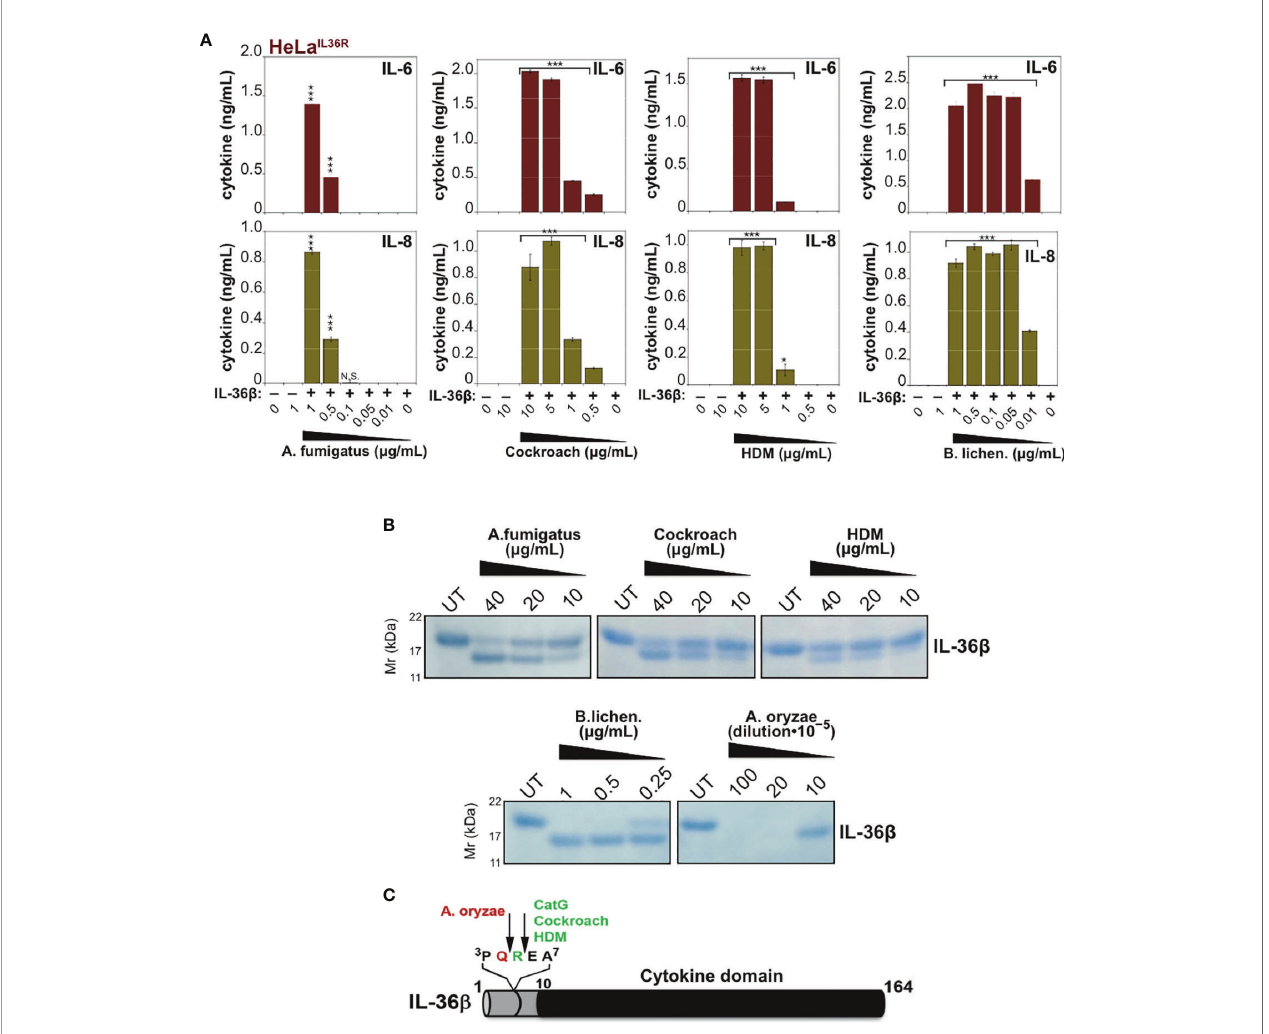
FIGURE 6 | Mapping cleavage sites within IL-36 b for proteases associated with Aspergillus fumigatus , cockroach, house dust mite and Bacillus licheniformis. (A) HeLa IL-36R cells were stimulated with 2 nM of full-length human IL-36 b , either untreated, or after incubation for 2 h at 37°C with the indicated concentrations of allergen extracts. After 24 h, IL-6 and IL-8 cytokine concentrations in cell culture supernatants were measured by ELISA. (B) Recombinant human IL-36 b FL (4 µg) was incubated for 2 h at 37°C in the presence or absence of the indicated concentrations of allergen extracts, followed by SDS-PAGE analysis. (C) Schematic representation of full-length IL-36 b with cleavage sites for cathepsin G and allergen extracts indicated. Error bars represent the mean of triplicate determinations from representative experiments. ***p < 0.001, *p < 0.1, Student ’ s t test. N.S., Not Signi fi